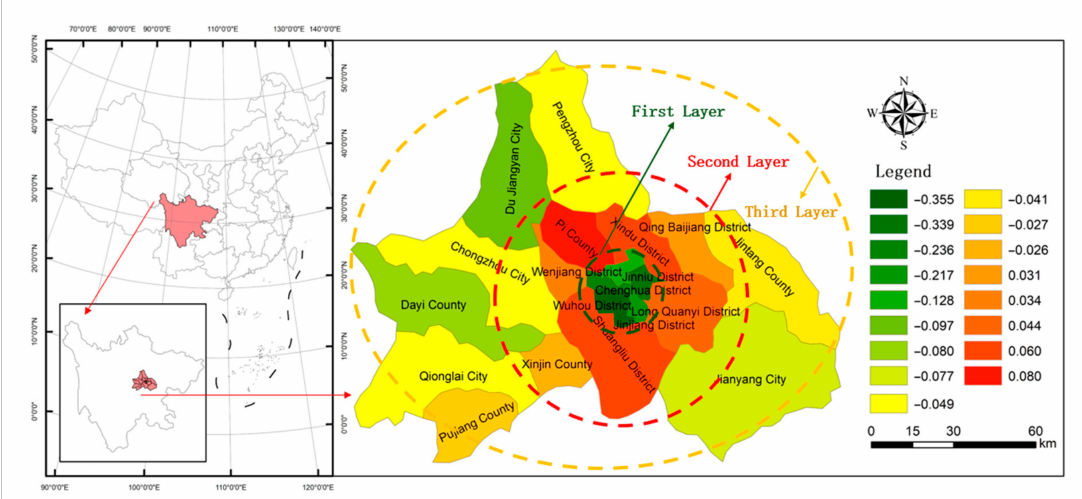
Figure 6. Spatial di ff erences in the comprehensive benefit from the external environment of ecological compensation for cultivated land protection in